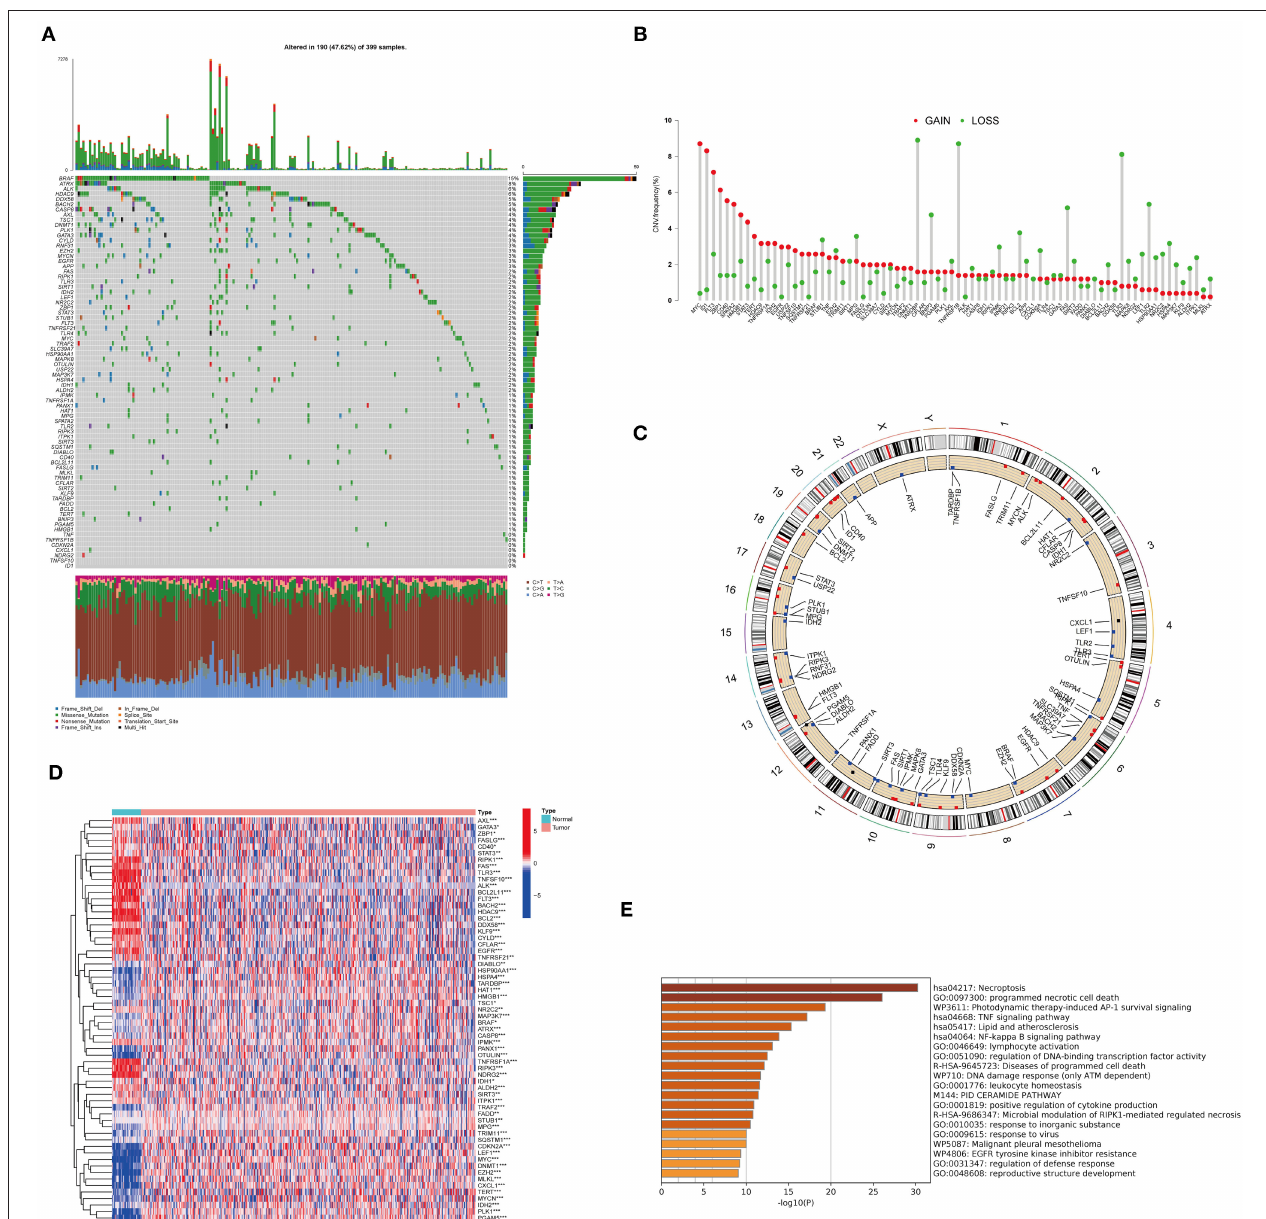
FIGURE 1 | Characteristics and differences of necroptosis-related regulators (NRGs) in CC. (A) Mutation landscape of 399 colon cancer patients from the TCGA-CORD cohort. (B) The frequency of CNV variation in NRGs is common. Pink dots: amplification frequency; green dots: deletion frequency. (C) Location of CNV alterations of NRGs on chromosomes. (D) Heatmap of DENRGs expression in the TCGA cohort (* P < 0.05, ** P < 0.01, *** P < 0.001). (E) Functional annotation of differentially expressed necroptosis-related genes using